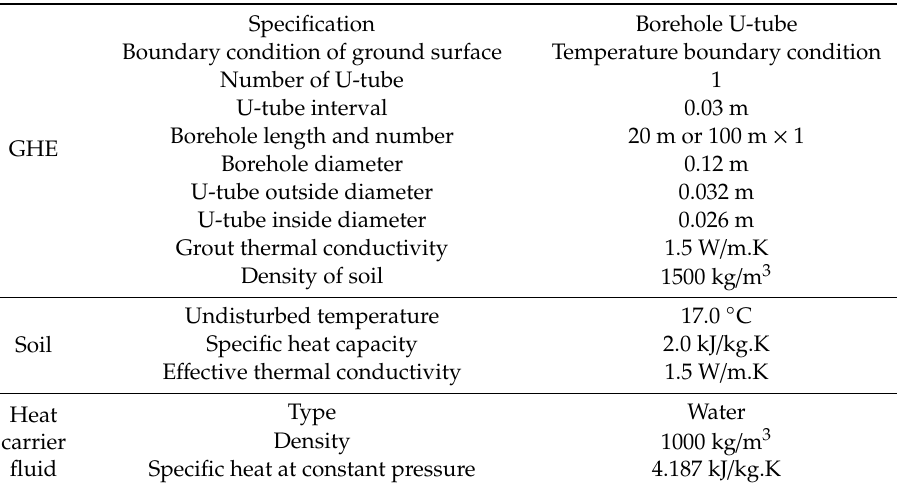
Figure 6. Schematic diagram of the TRT. Table 2. Calculation